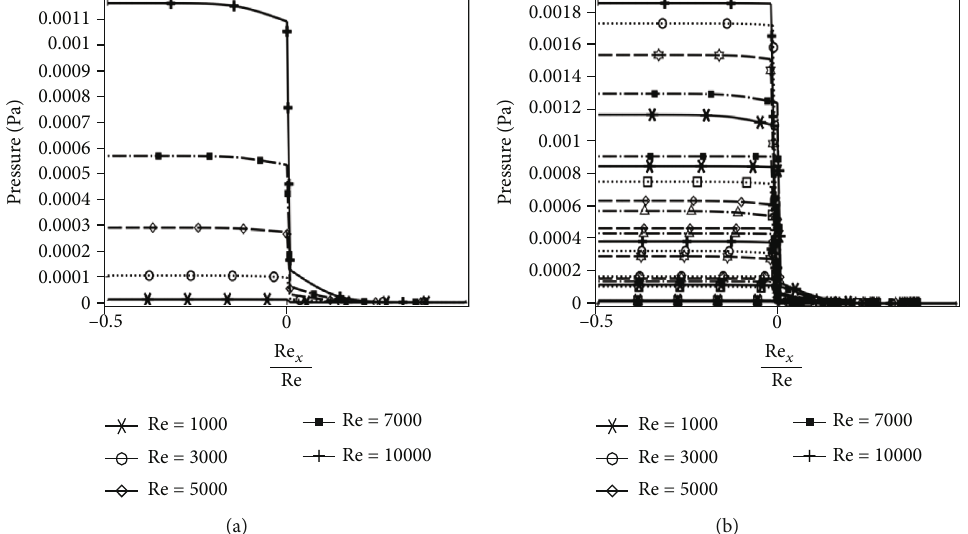
x -axis at angle 45 at the Reynolds number; (b) Re Figure 13: (a) Re x /Re vs. the